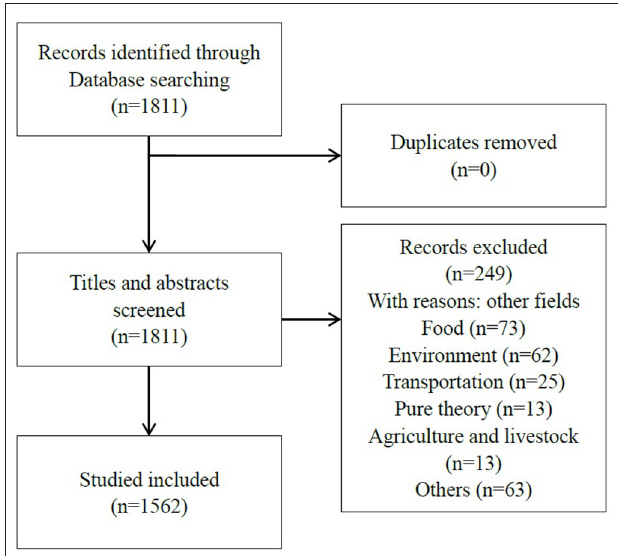
FIGURE 1 | Flow diagram of study selection.